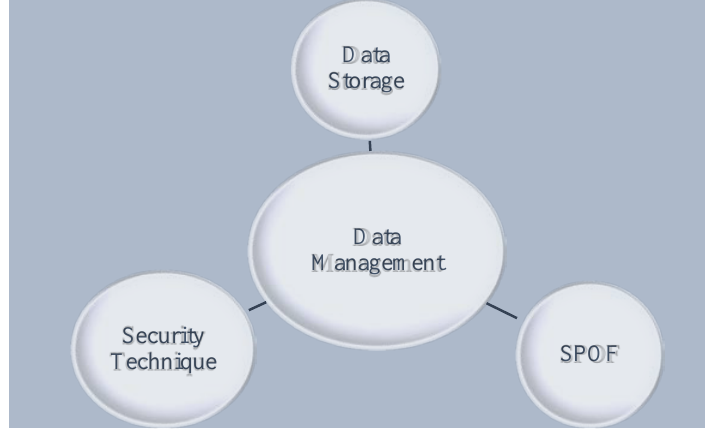
Figure 5. Major concerns of data management.